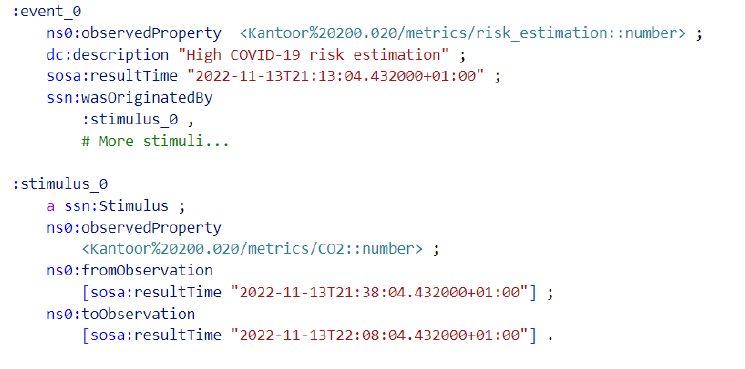
Figure 7. Semantic annotation in Turtle format of a “High COVID-19 risk estimation” event produced by Streaming MASSIF. The event is linked to the COVID-19 aerosol transmission risk estimation metric of a room, the occurrence time and multiple stimuli.